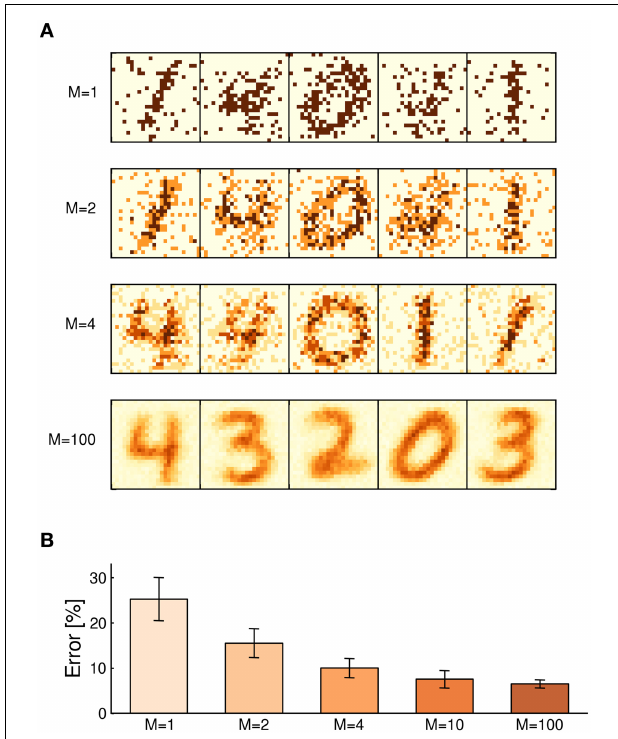
FIGURE 4 | Influence of the synaptic resolution. (A) Examples of learned weight matrices with different numbers of constituents M per synapse. Even binary weights with only one stochastic switch learn to maintain a coarse image of prototypic digits. In the limit of large M , compound synapses support a quasi-continuous weight spectrum. (B) Classification error for different weight resolutions after 5000 s of learning, based on 20 independently trained networks for each value of M . Errorbars: SD among